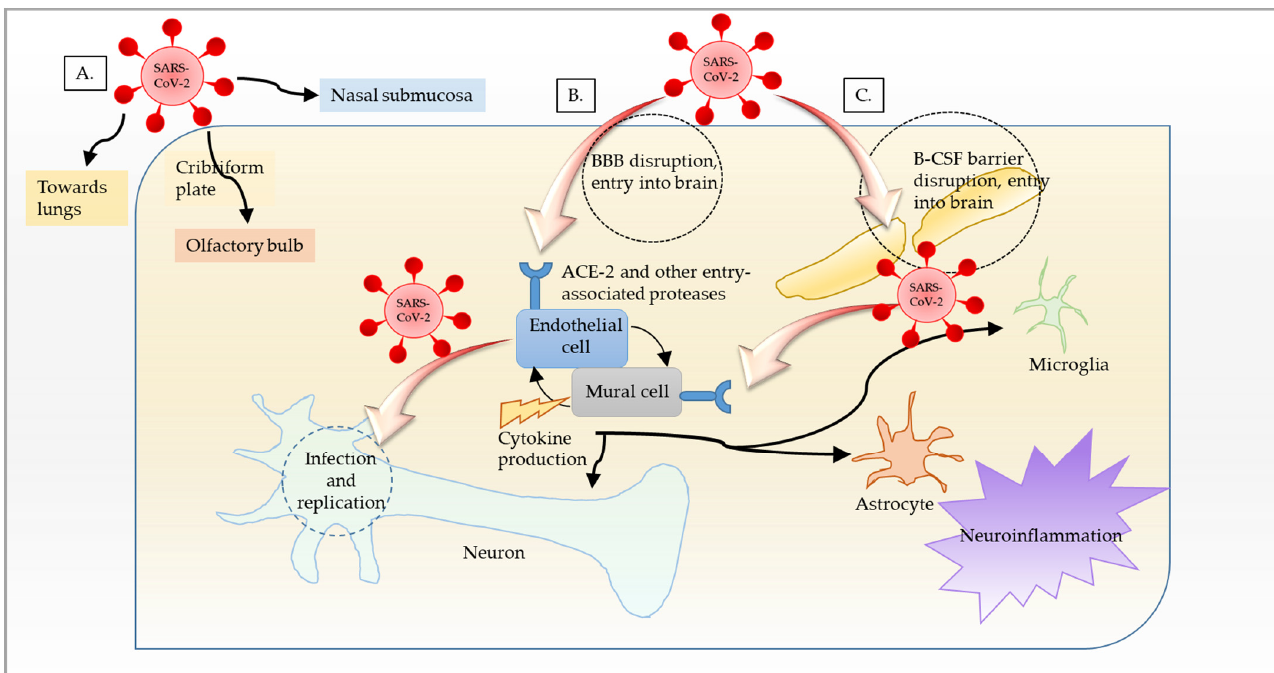
Figure 1. Schematic representation of SARS-CoV-2 entry routes. ( A ) SARS-CoV-2 enters the nasal cavity via droplets. It subsequently enters the blood through nasal submucosa. It may further obtain access to the olfactory nerves and, thus, the olfactory bulb by moving upstream. SARS-CoV-2 enters the lungs, crosses the thin alveolar membrane, and enters the blood to access all organs, including the brain. ( B ) SARS-CoV-2 binds to ACE2 receptor and gains entry into endothelial cells, infects, and replicates in cells of neuronal origin, leading to inflammation and opening of the BBB. Inflammation then spreads to vascular mural cells and other brain cells, such as microglia and astrocytes. The resulting alteration in neuronal function and inflammation results in encephalopathy in